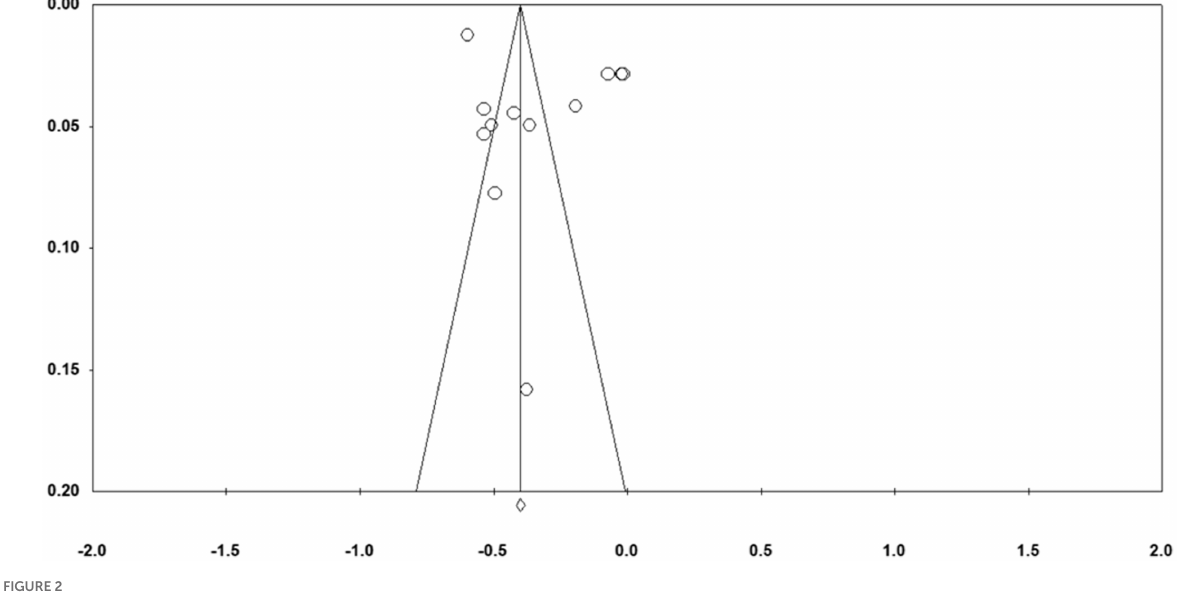
FIGURE 2 Funnel plot of standard error by Fisher’s Z